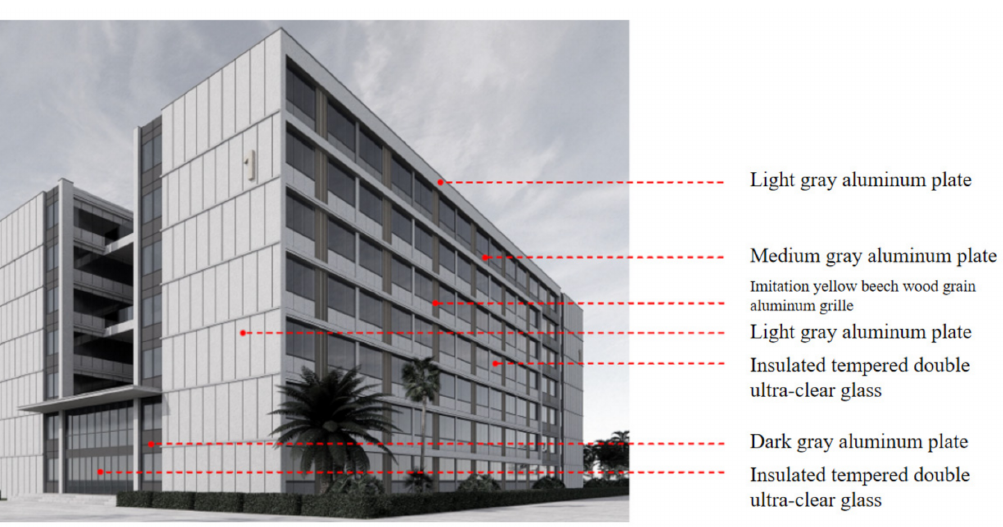
Figure 3. MiC elevation detail